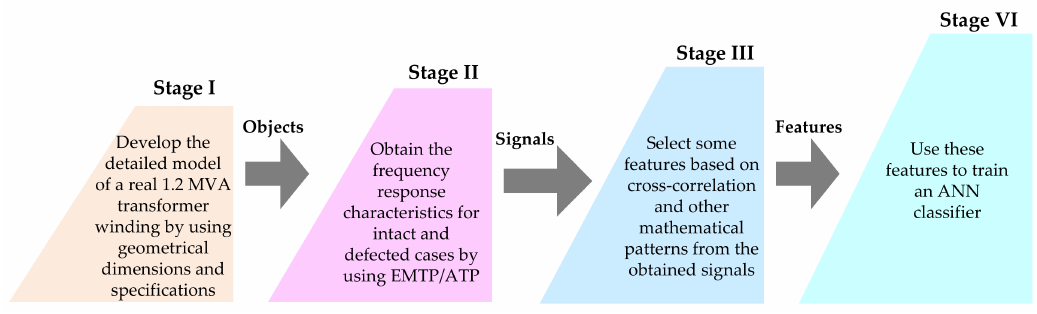
Figure 2. The principle of the model developed in